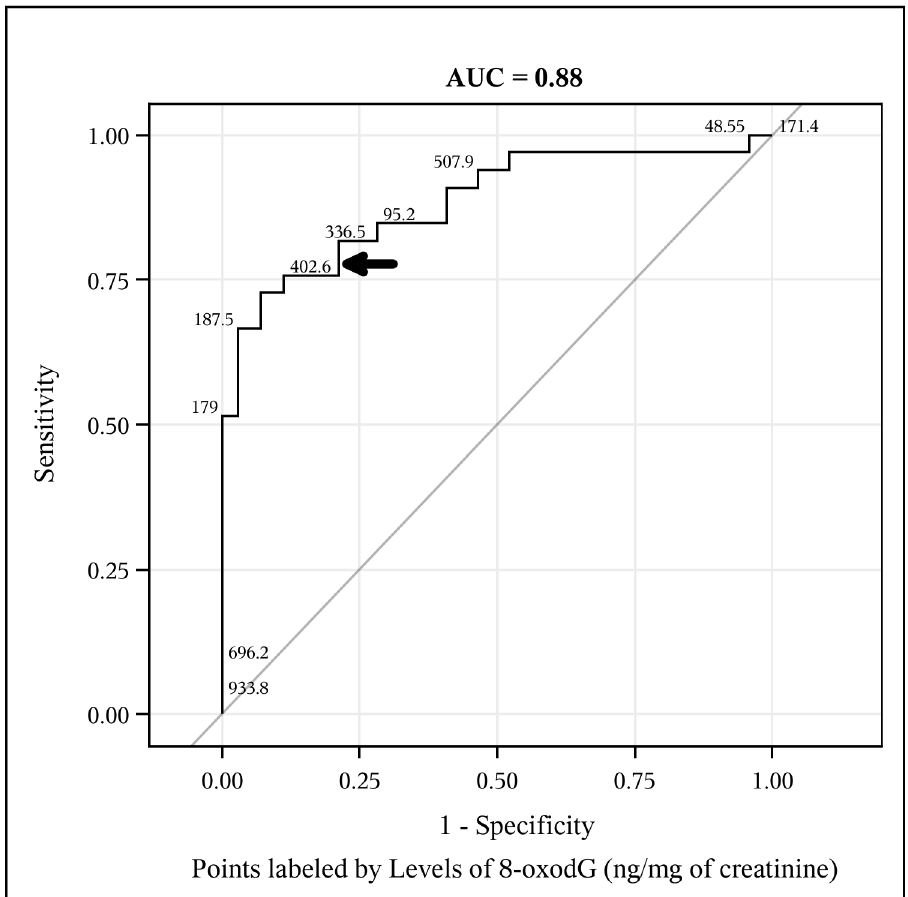
Fig 4. Levels of urine 8-oxodG detected by immunoassay can identify O . viverrini infected individuals with intrahepatic cholangiocarcinoma (CCA). The Receiver Operating Characteristic (ROC) curve illustrates the predictive power of urine 8-oxodG in identifying O . viverrini -induced CCA individuals. The predictive power of the assay measured by the area under curve (AUC) is 88%. The curve is labeled with selected actual amounts of 8-oxodG (ng/mg) detected in study participants; labeled points are presented, at random, in a way to maximize legibility. The model used to construct the ROC curve included negative controls (EN and APF- individuals, n = 71) and CCA individuals (n = 33). The bold arrow points to the concentration of urine 8 oxodG identified as an optimal diagnostic threshold for corroborating CCA status.